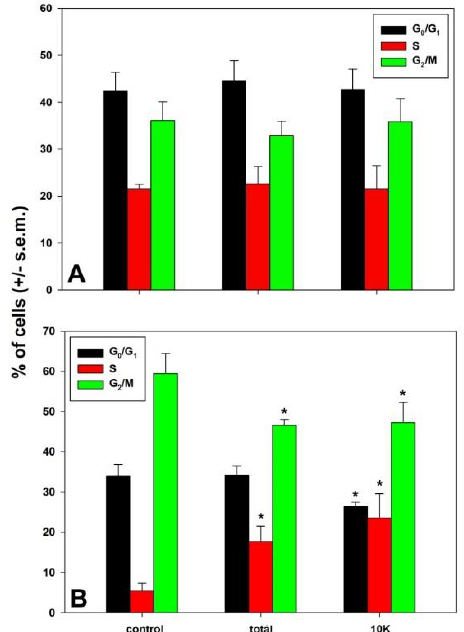
Figure 3. Cell cycle distribution of MDA-MB-231 cells exposed to total extracts and 10K fractions for 24 ( A ) and 48 h ( B ), compared to control conditions. Error bars correspond to the standard error of the mean (s.e.m.) of three independent measurements. * p < 0.05.